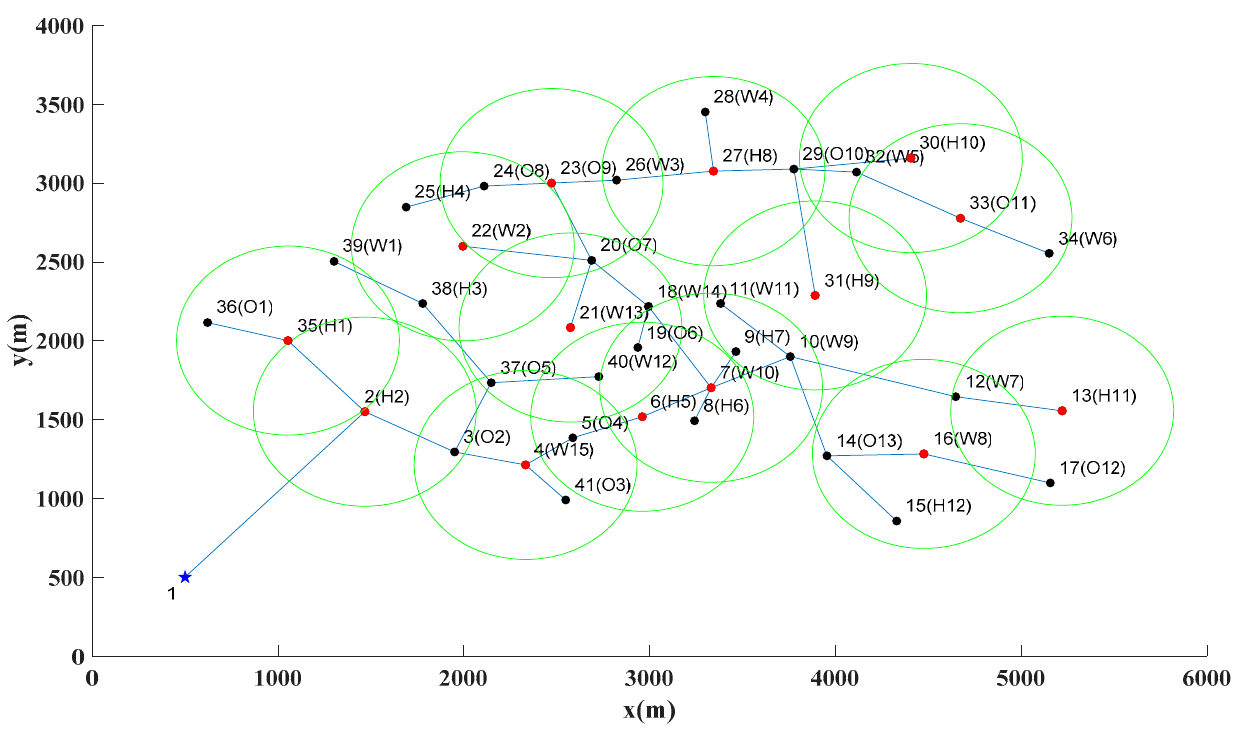
Figure 3. Actual fast charging station planning area.